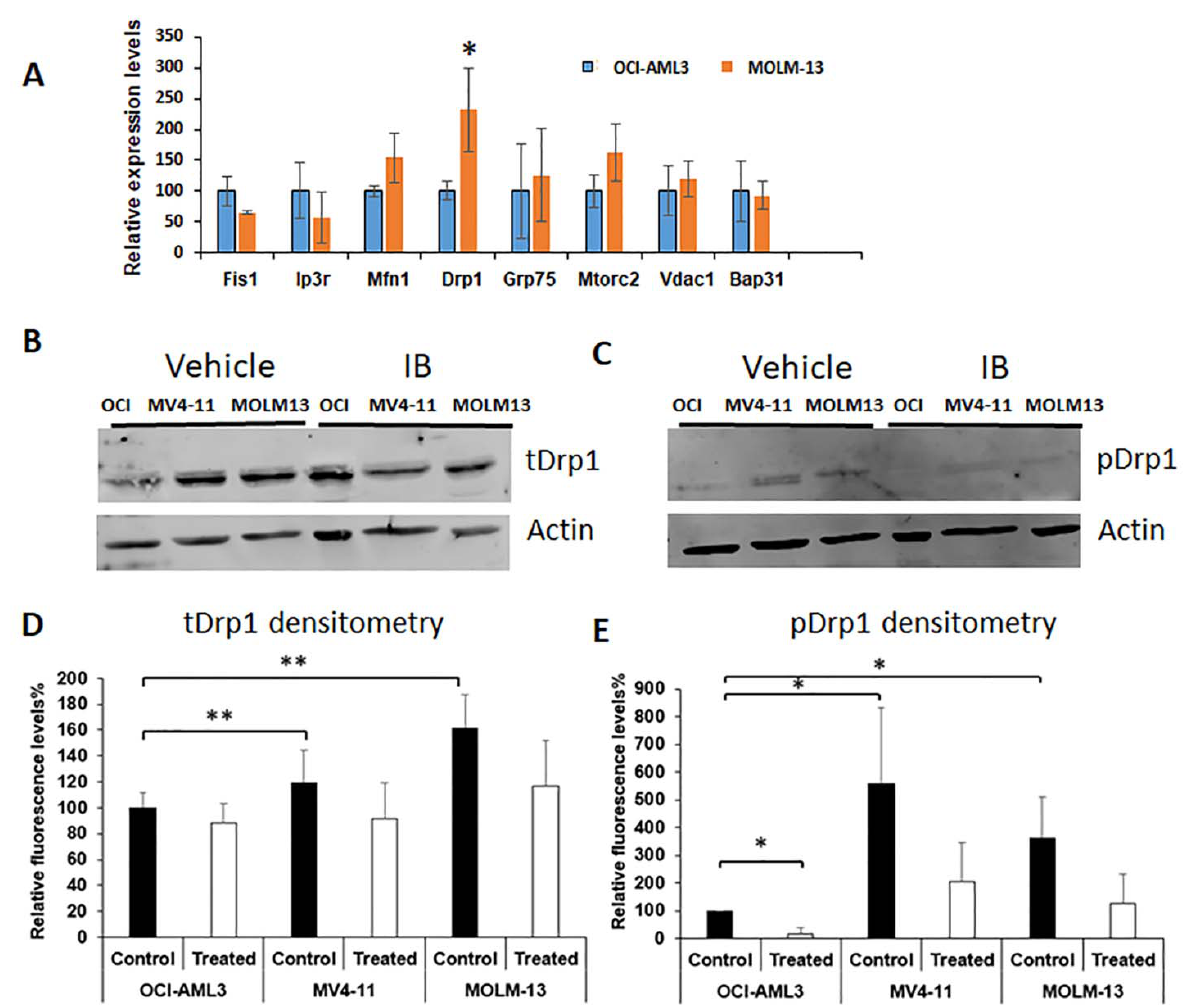
Figure 6. IB suppresses phosphorylation of DRP1 in Flt3-ITD + cells. ( A ) A panel of genes related to the ER–mitochondria interface were assayed by real-time qRT-PCR. The panel included Fis1, Ip3r, Mfn1, Drp1, Grp75, Mtorc2, Vdac1, and Bap31 ( n = 3 for all except Drp1 where n = 7). p values were calculated relative to OCI-AML3 cells. ( B ) Western blot analysis for total Drp1 protein with β -actin as the loading control. ( C ) Western blot analysis for phospho-Drp1 protein with β -actin as the loading control. ( D , E ) Densitometry analysis was performed and quantitation is shown for replicates of the Western blots in panels C and D. n = 3 and p values were calculated with comparisons as shown between either OCI-AML3 cells or with or without treatment. * p < 0.05; ** p < 0.01.